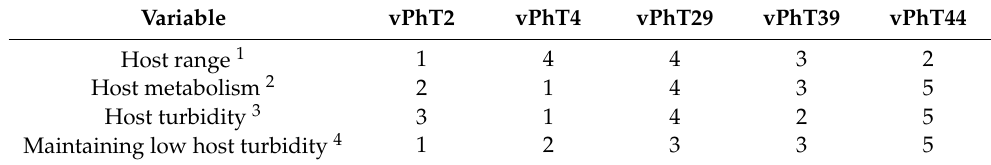
Bacteriophages that performed equivalently have been given the same ranking for that variable. 1 Host range (1 = broadest host range, 5 = narrowest host range). 2 Reduction in relative endpoint host metabolism (OD 540 of TTC assay) after 24 h incubation with the bacteriophage (1 = lowest metabolism, 5 = highest metabolism). 3 Reduction in endpoint host turbidity (OD 600 ) after 24 h incubation with the bacteriophage (1 = lowest turbidity, 5 =